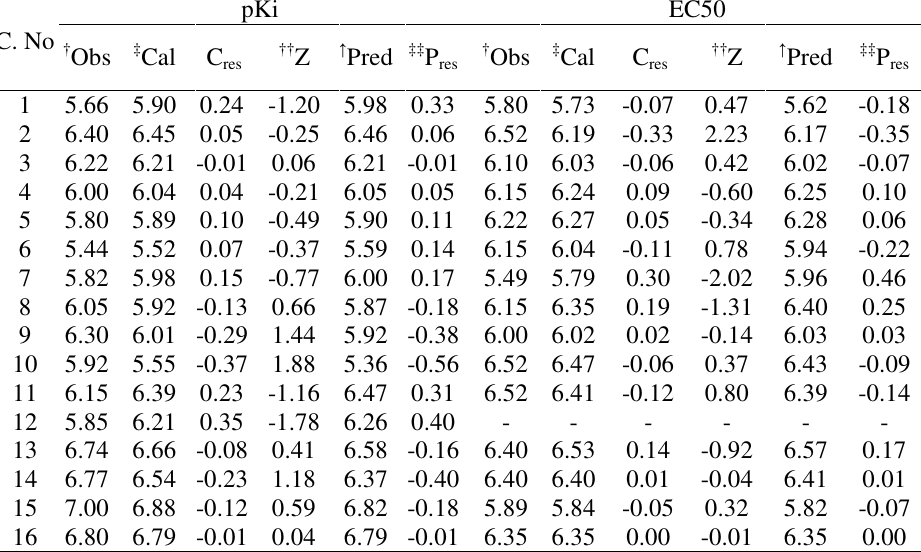
Table 2. PPAR- γ agonist activity of 5-substituted-2- benzoylaminobenzoic acid analogs using eqn 1 and 2 respectively